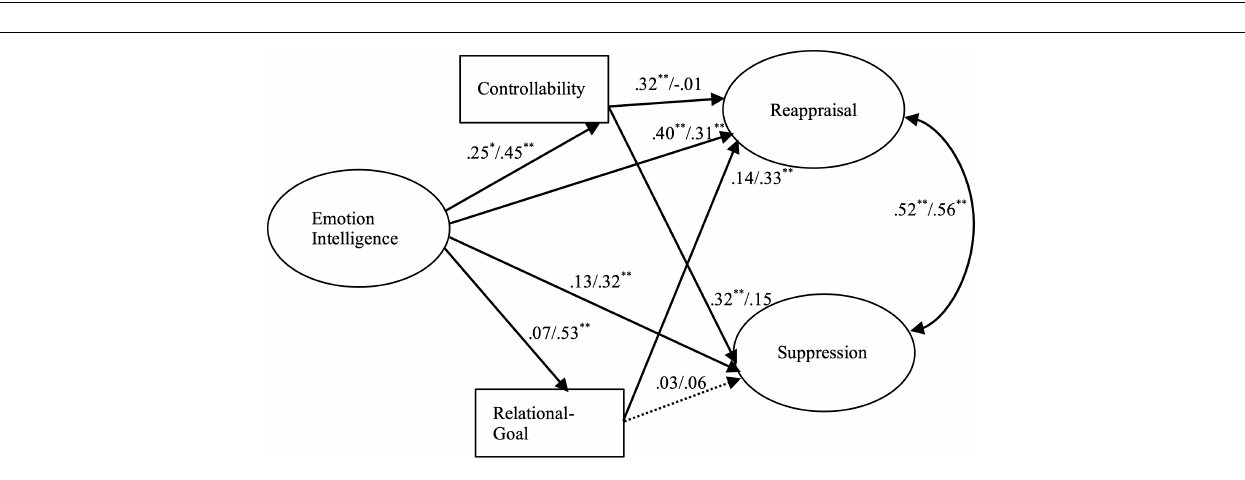
Frontiers in Psychology |